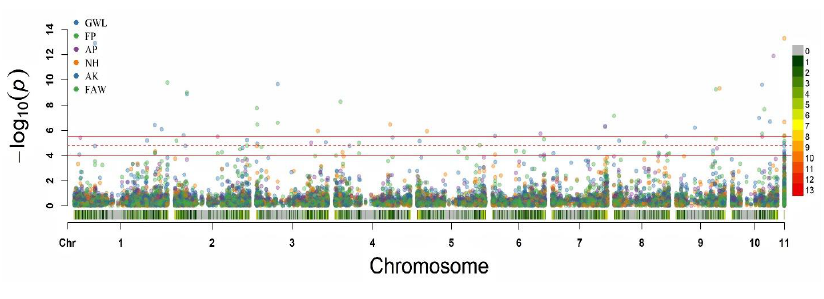
Figure 4. Combined Q–Q ( A ) and Manhattan ( B ) plots derived from the genome-wide association analysis for fall armyworm (FAW) damage and maize weevil (MW) traits. Bonferroni genome-wide significance levels of 0.01 (upper line), 0.05 (middle lines), and 0.3 (lower line) on B. Single- and multiple trait-associated traits.